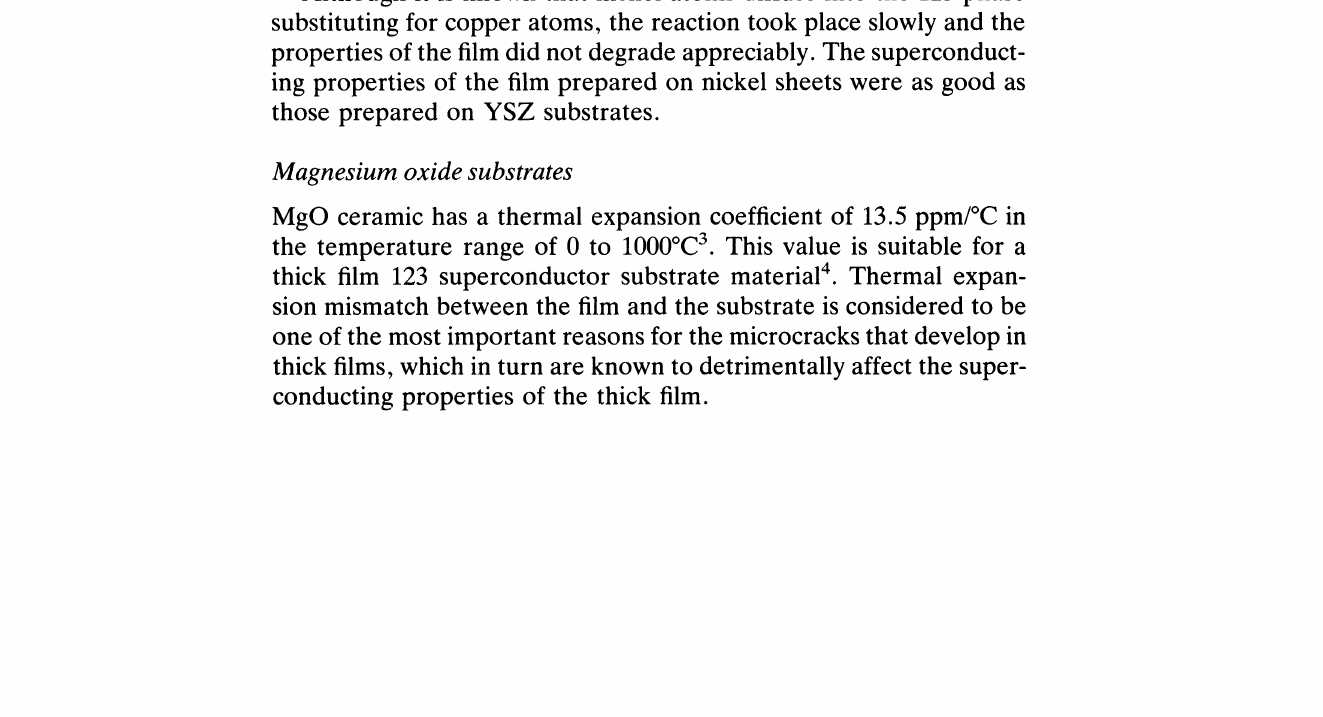
FIGURE 10 Resistance vs. temperature curve of a 123 superconducting thick film printed on a nickel